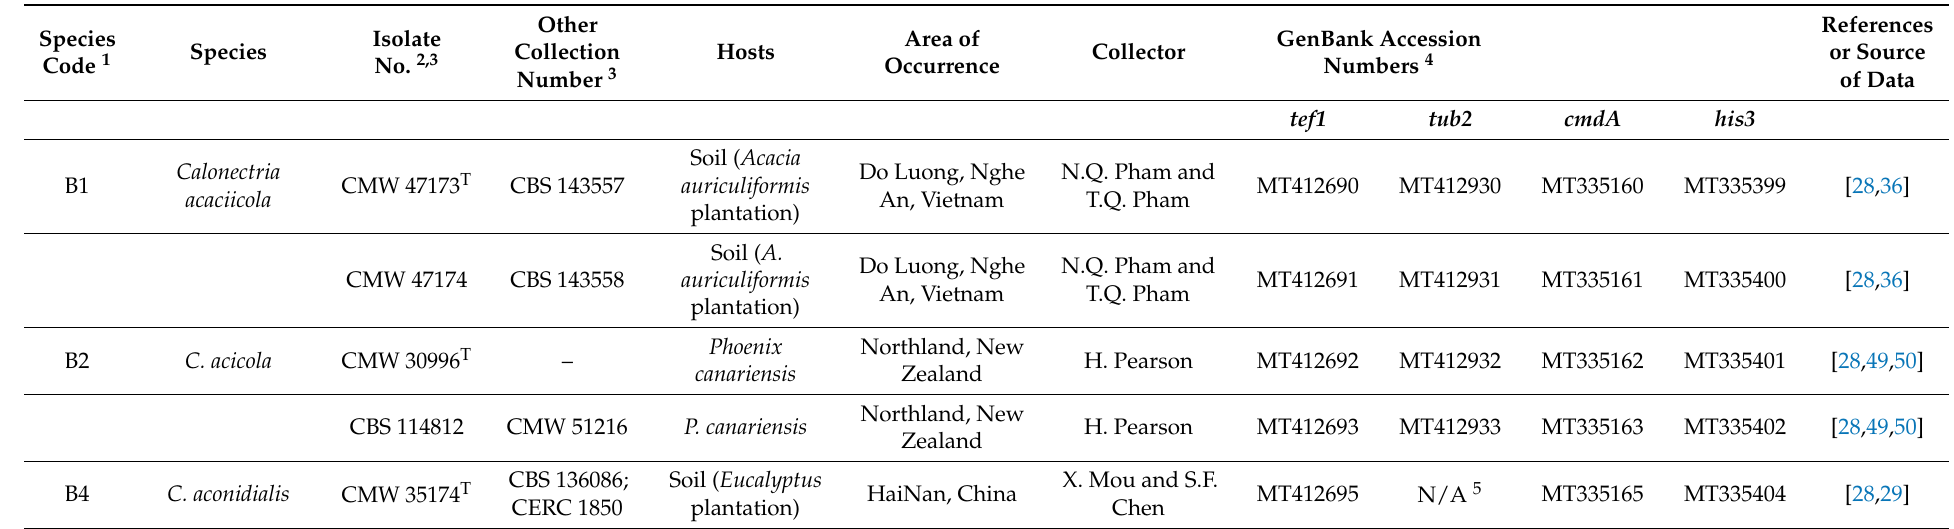
Table A2. Isolates from other studies and used in the phylogenetic analyses for this